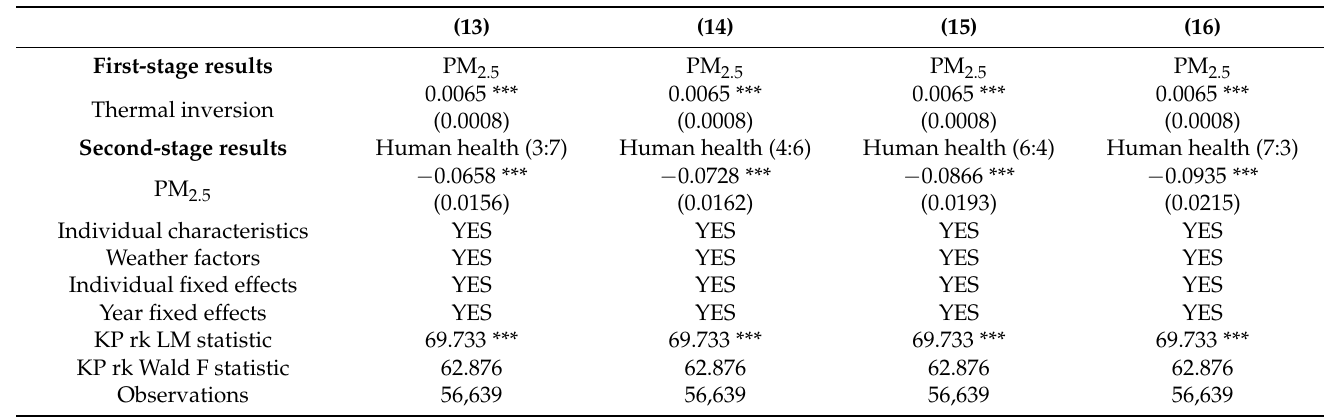
Table 6. Readjusting the ratio of physical health to mental